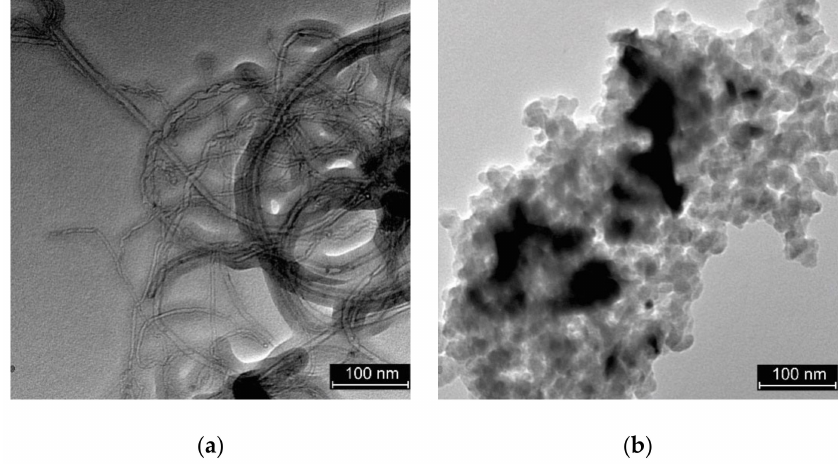
Figure 1. Transmission electron microscopy (TEM) images of: ( a ) molybdenum carbide supported on carbon nanotubes (Mo 2 C / CNT) and ( b ) molybdenum carbide supported on carbon xerogel (Mo 2 C /